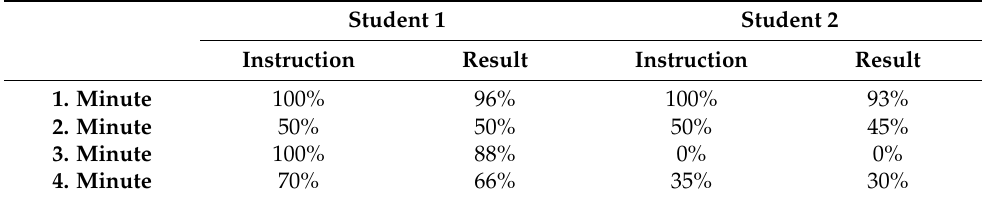
Table 4. Overall success of SECS—first scenario.